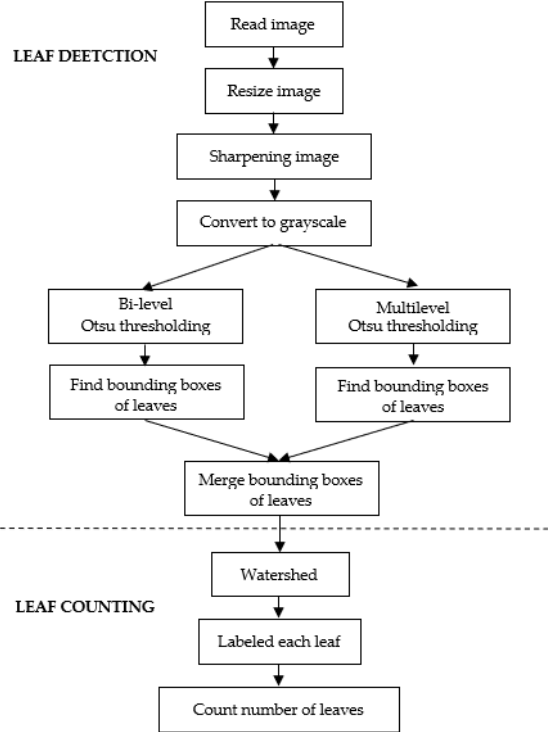
Figure 6. Flowchart of the proposed leaf detection and counting method. As described previously, our algorithm combines bi-level and multilevel thresholding to accommodate the day and nighttime images; therefore, both bi-level Otsu thresholding and multilevel Otsu thresholding were applied to the grayscale image. Otsu thresholding is an adaptive image segmentation technique that selects the threshold